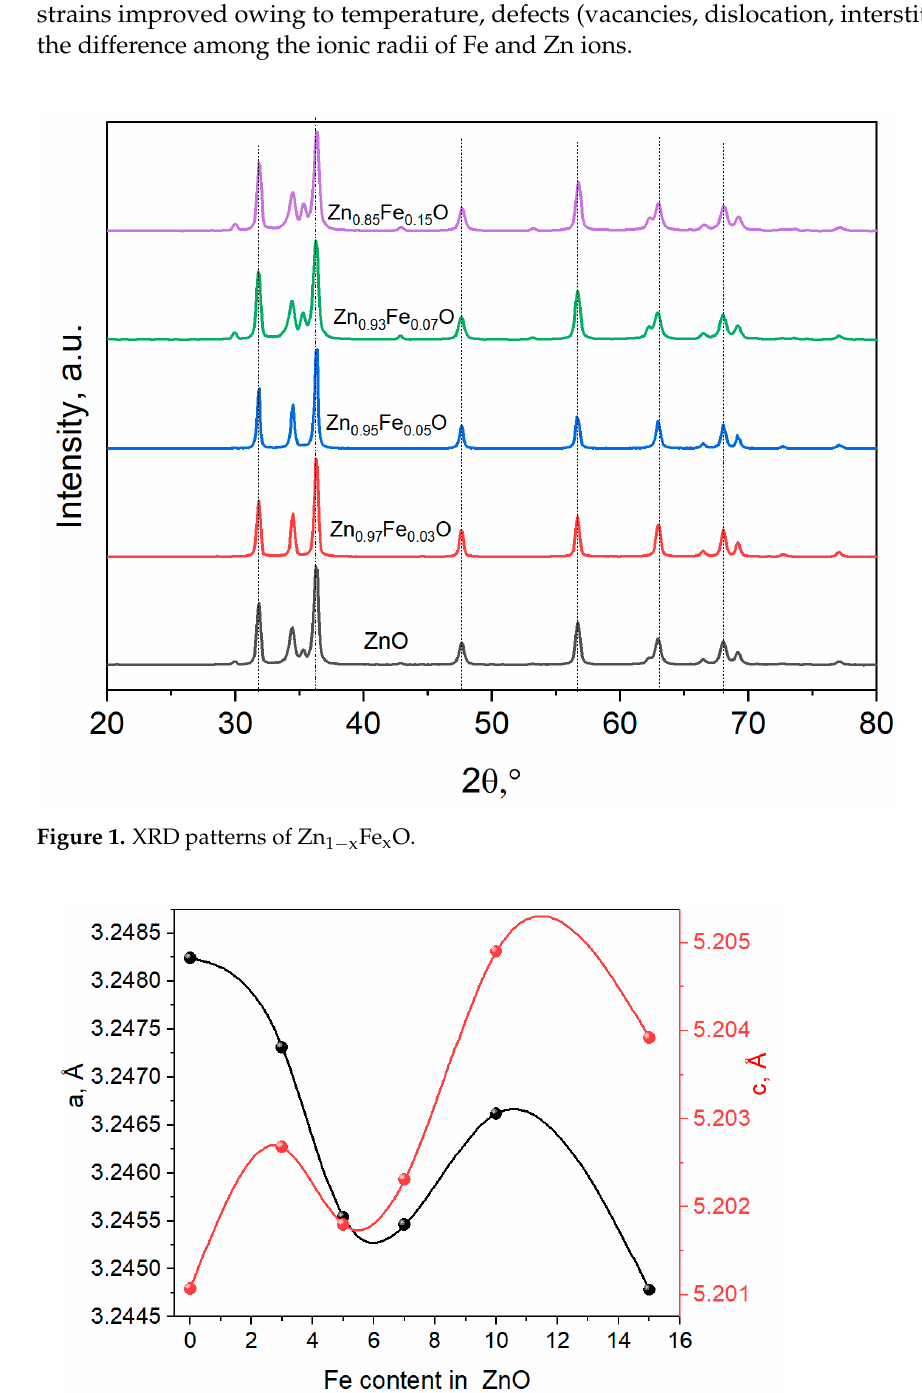
Figure 2. Variation of lattice parameters drives from Rietveld refinements (XRD patterns of Zn1- xFexO (x = 0 (a, 0.03, 0.05, 0.07, and 0.15). Further, the lattice constants ( a , c ), unit cell volume ( V ), degree of distortion ( R ), and bond length (along the c -axis) were carefully calculated using the Rietveld analysis pro- vided in the package. The obtained data are plotted in Figure 2.